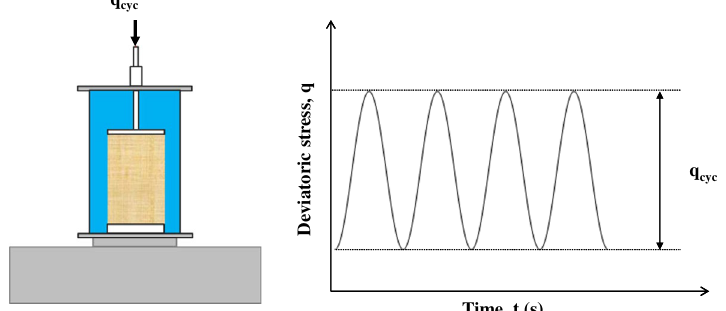
Fig. 3 State of stress during cyclic loading